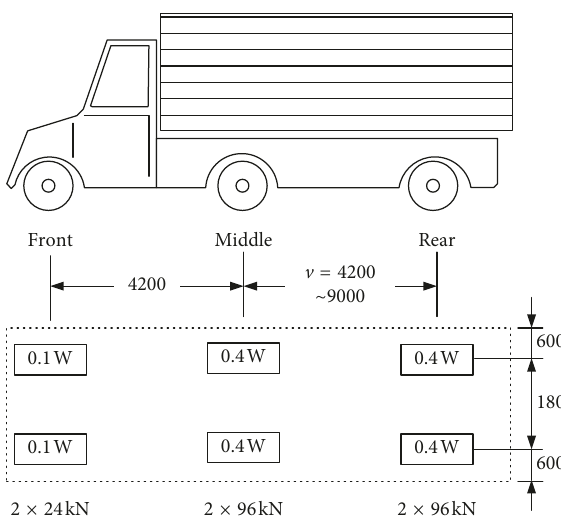
Figure 8: DB-24 truck load model (in mm).